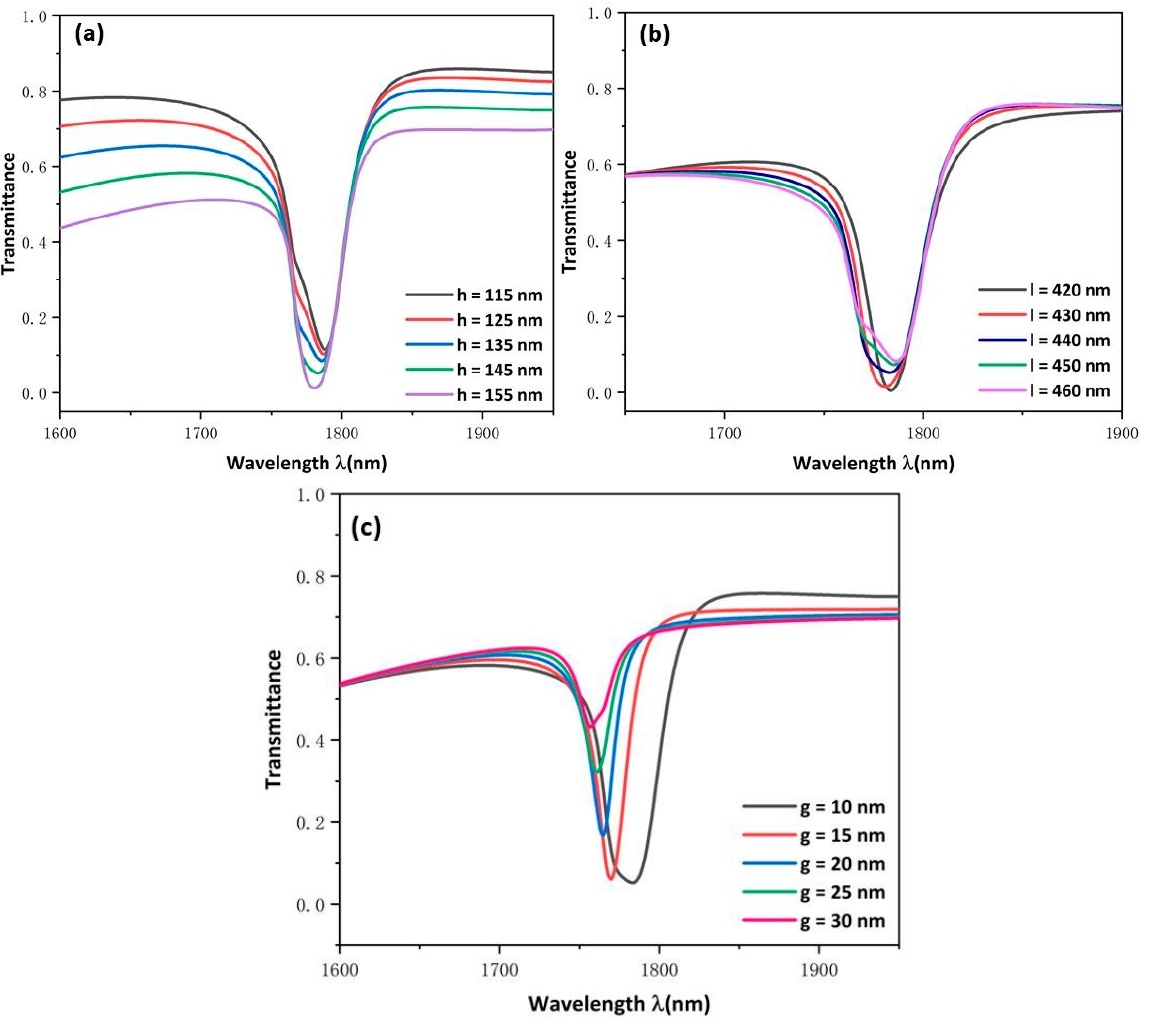
Figure 6. Transmission spectra at ( a ) disparate heights of rectangular baffles; ( b ) disparate distances between the two rectangular baffles; ( c ) various coupling gaps.